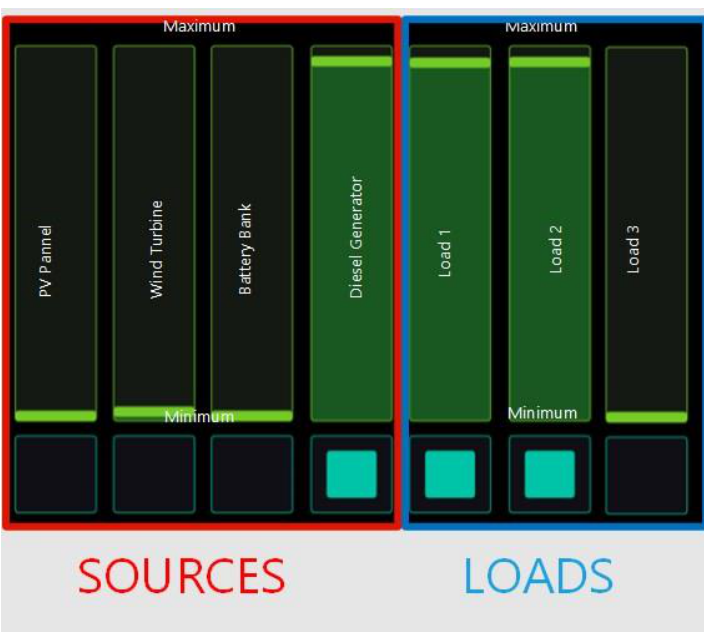
Figure 9. Monitoring Screen with DG ON and Load 3